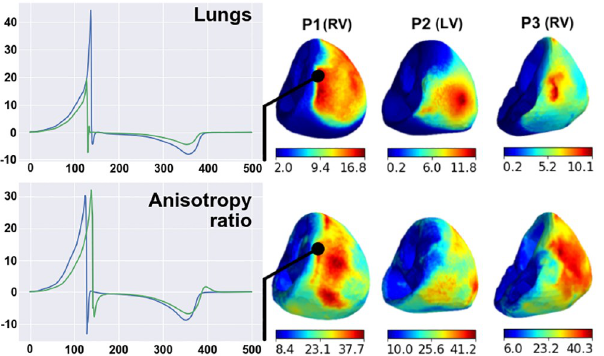
Fig 10. Examples of regional RED maps for the extracellular potential under variation in lung conductivity (upper panels) and the myocardial anisotropy ratio (lower panes) for the P1(RV), P2(LV), and P3(RV) models. The figure design is the same as Figs 8 and